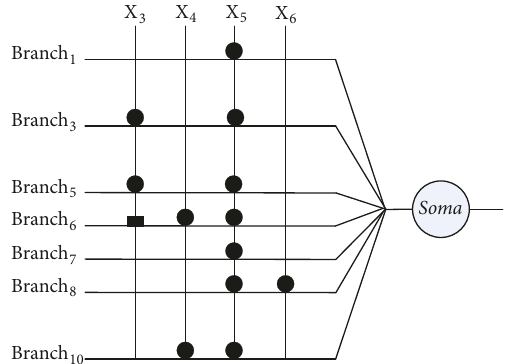
Figure 11: The final structure of the Qualitative Bankruptcy data set.